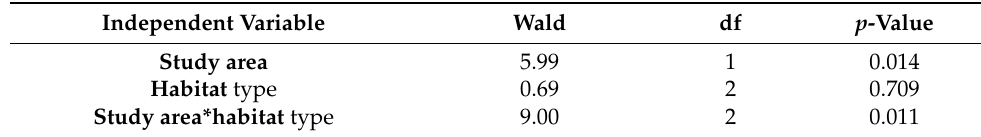
Table 2. The effect of study area and habitat type, and its interaction on the course of cumulative survival of nests over time. Cox proportional hazards analysis.